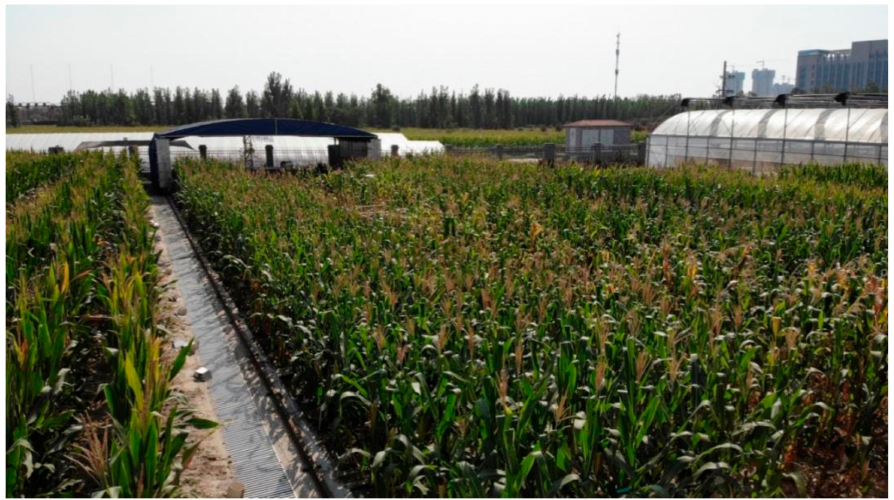
Figure 1. Field experiment in Xinxiang Agricultural Water and Soil Environment Field Scientific Observation and Experiment Station, Chinese Academy of Agricultural